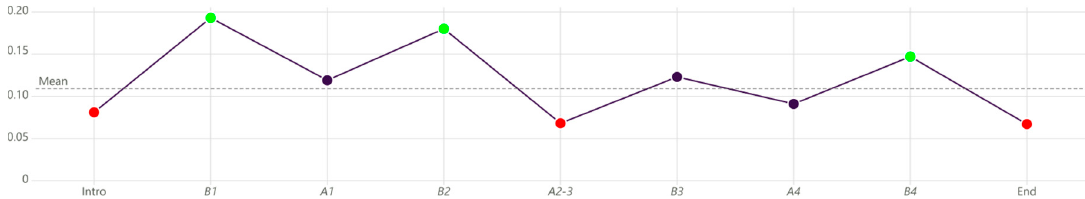
Figure 7. Cynewulfian compounds per section.